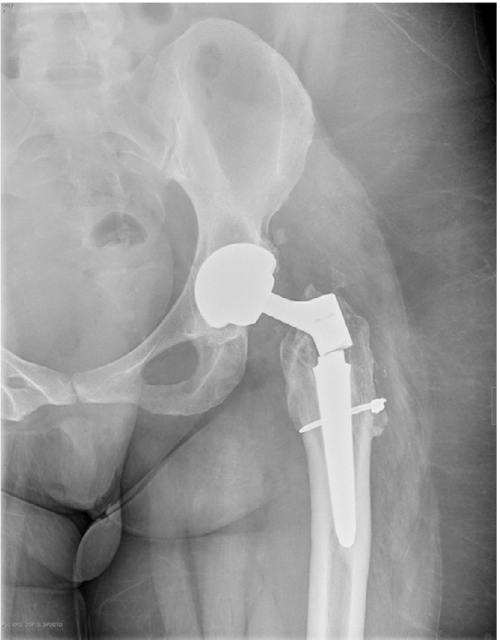
Figure 3. Neck-stem junction breaking in 1st revision implant after atraumatic pain two years after the revision. The rupture is localized on the thread at the neck-stem junction. The neck was virus (135 (cid:2) ) in